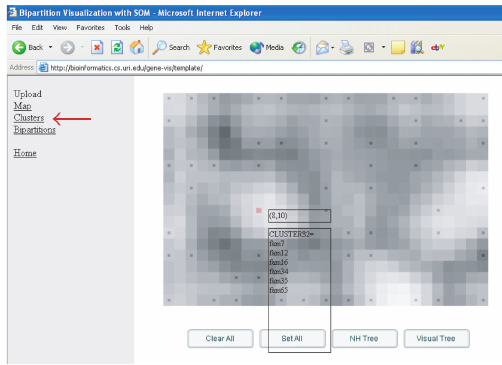
Figure 4: A typical visualization computed by